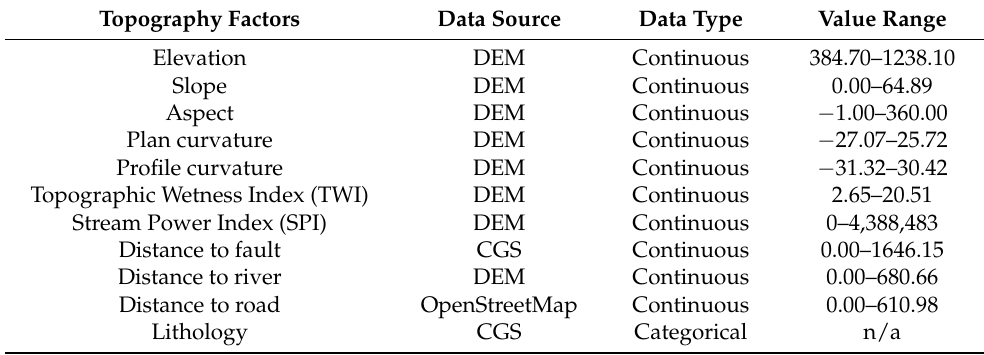
Table 1. The information about factors selected in the